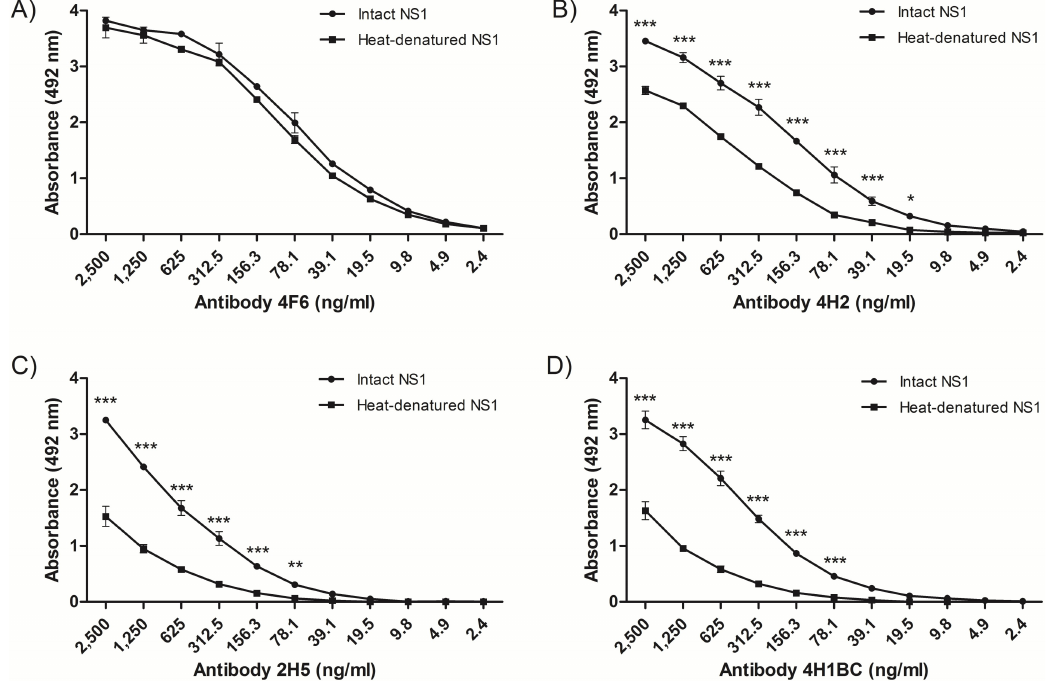
Figure 1. Characterization of nonstructural protein 1-specific (NS1) monoclonal antibodies (mAbs) reactivity by enzyme-linked immunosorbent assay (ELISA). Reactivity of mAbs to heated-treated or intact rNS1, as solid phase-bound antigens. The mAbs 4F6 ( A ), 4H2 ( B ), 2H5 ( C ) and 4H1BC ( D ) were serially diluted (log2) from an initial concentration of 2.5 µ g/mL. Each well was adsorbed with 400 ng of rNS1. Heat denaturation was performed at 100 ◦ C for 10 min. Statistical analyses were performed by two-way variance analysis followed by Bonferroni’s post-test. (*** p < 0.01; ** p < 0.1; * p <